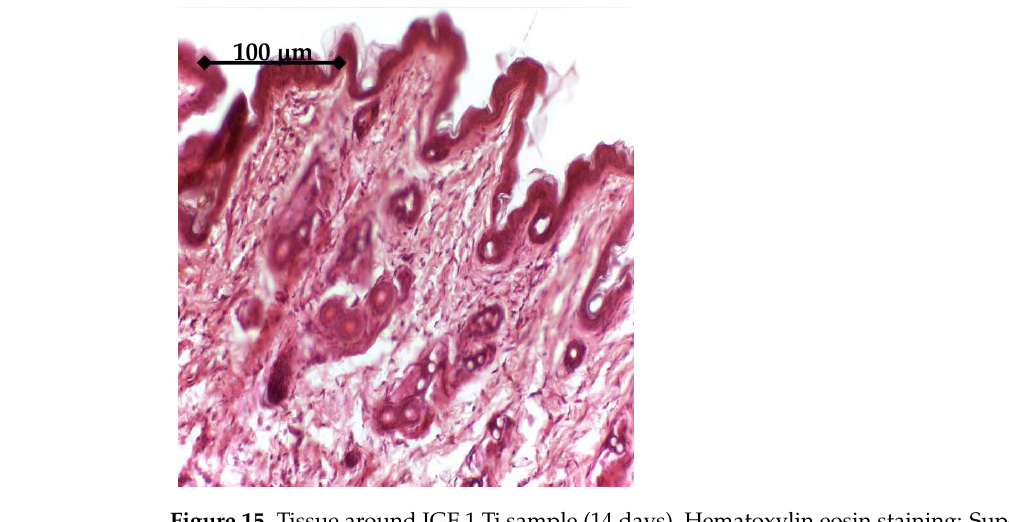
Figure 17. Tissue around IGF1 implant, 14 days, MicroCT image.